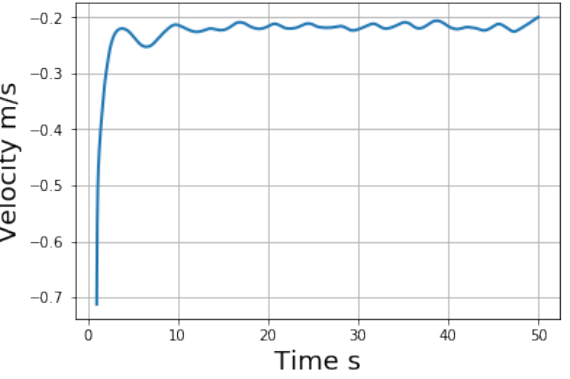
Figure 4. Sedimentation velocity of a single DEM particle among SPH particles.